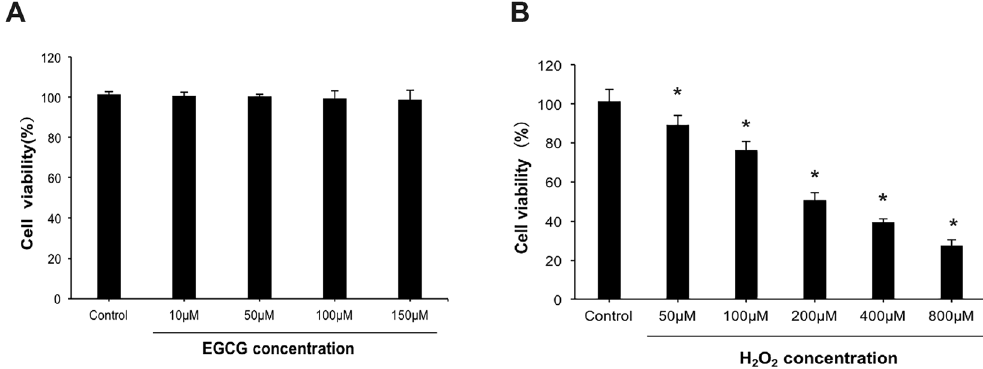
Figure 1. The effect of EGCG on cell viability. ( A ) VSMCs were incubated with 10, 50, 100, or 150 μ M EGCG for 2 h and cell viability was assessed using CCK-8 assay. ( B ) CCK-8 assay cytotoxic effect of H 2 O 2 on VSMCs after incubation with 50, 100, 200, 400, or 800 μ M H 2 O 2 for 30 min. Results were expressed as mean ± S.D.(n = 5). * P < 0.05 vs. control